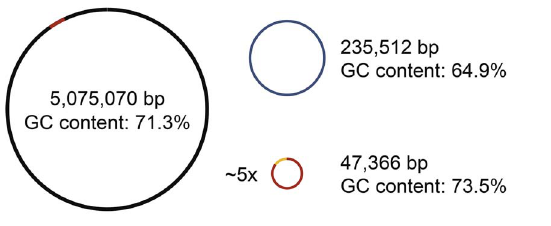
Figure 1. De novo genome assembly results for Rubrivivax gelatinosus CBS, resulting in one bacterial chromosome and two satellite DNA elements. The common section of the small satellite and the chromosome are highlighted in red. Not drawn to